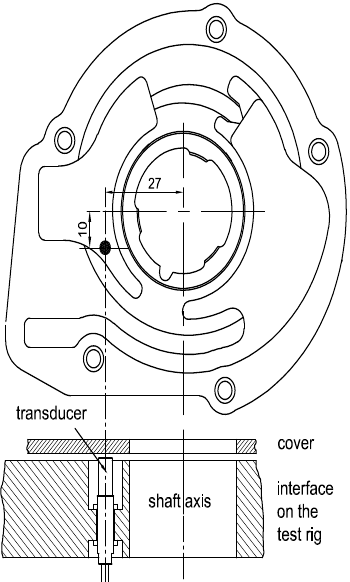
Figure 7. Mounting of the proximity transducer on the test rig and position with respect to the pump. Figure unit = mm.